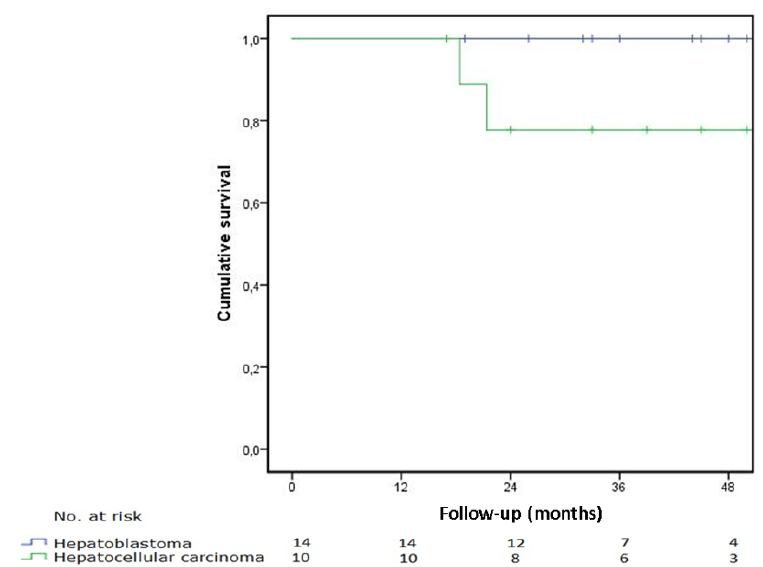
Figure 2. Disease-free survival of HB and HCC patients.